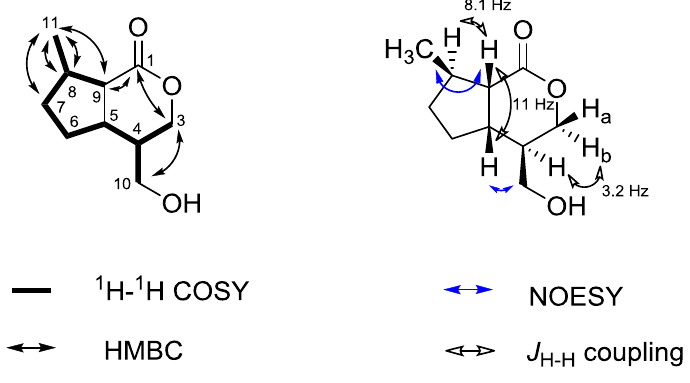
Figure 4. Key 1 H- 1 H-COSY, HMBC and NOESY correlations of villoside aglycone 5